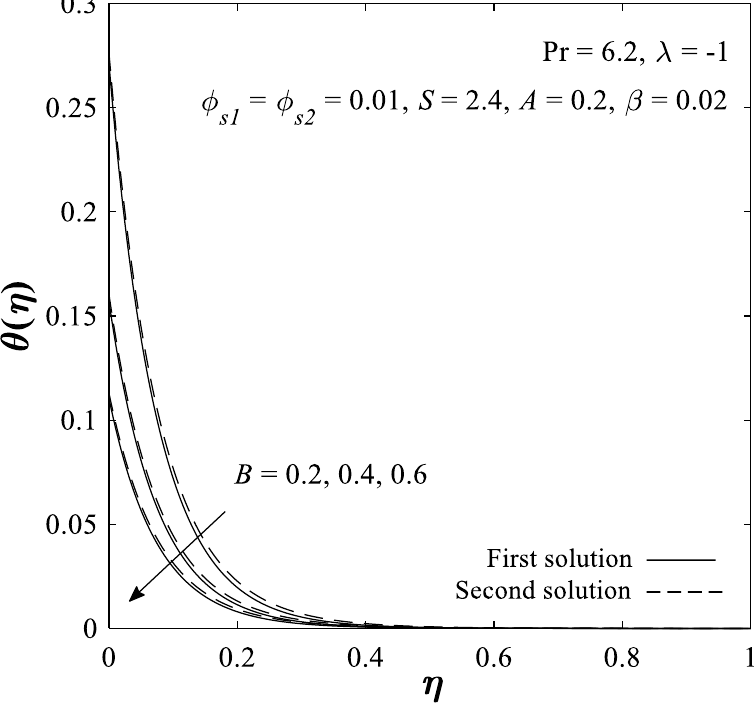
Figure 16. Temperature profile θ ( η ) for varied B .